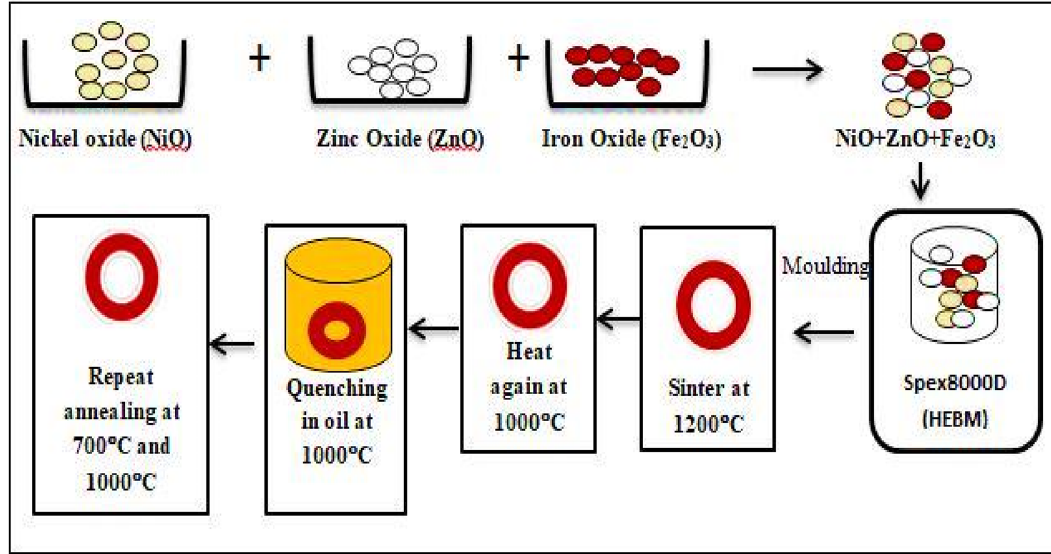
Figure 1. Schematic diagram of the synthesis of nickel zinc ferrite (Ni 0.5 Zn 0.5 Fe 2 O 4 ) and subsequent heat treatment